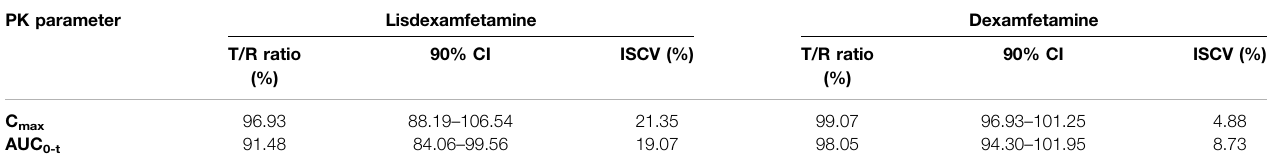
TABLE 3 | Lisdexamfetamine and dexamfetamine point estimates (% T/R ratios), 90%con fi dence intervals (90% CIs) and intra-subject coef fi cients ofvariation (% ISCVs) for the primary PK parameters C max and AUC 0-t (N = 29). PK